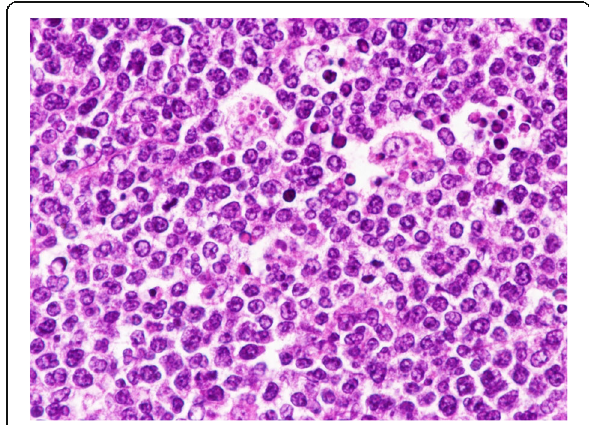
Fig. 1 Histopathological findings of thyroid Burkitt ’ s lymphoma. The tumor cells are composed of round, intermediate-sized cells with round nuclei admixed with scattered tingible body macrophages